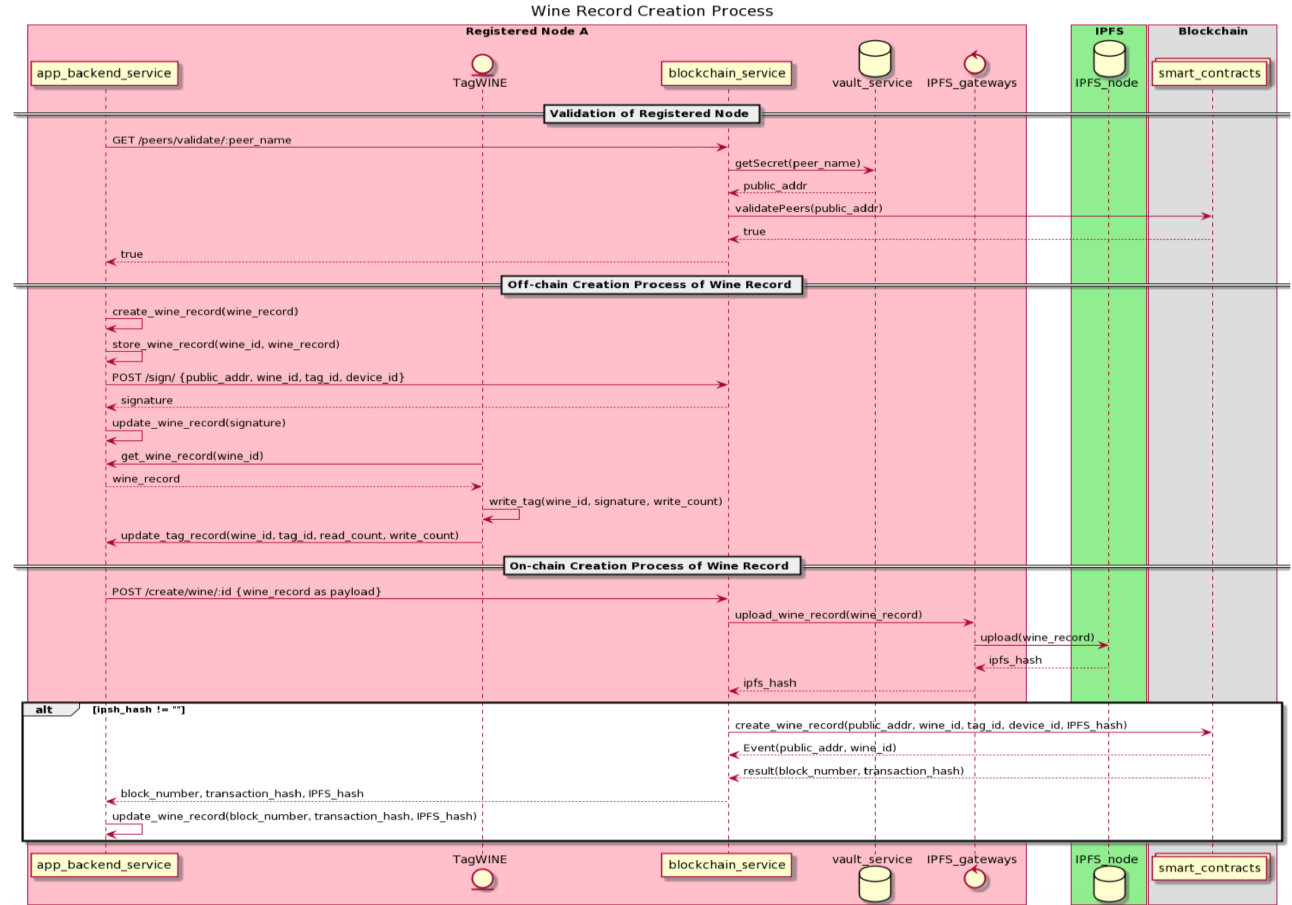
Figure 12. The Wine Record Creation